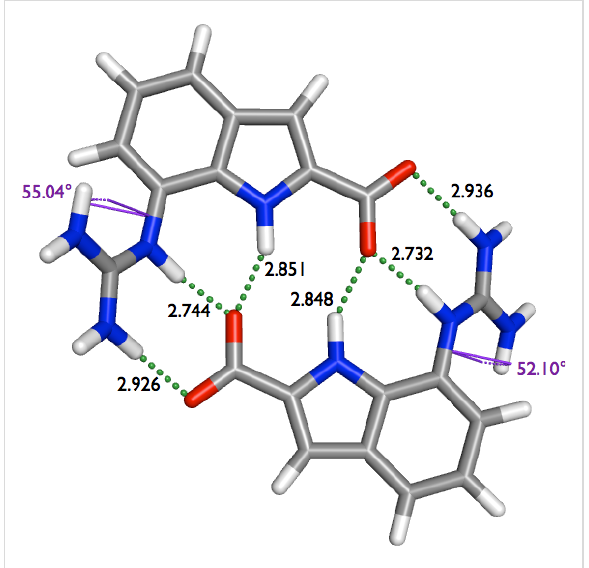
Figure 9: Energy-minimized structure for dimer 2 · 2 with hydrogen bond distances (Å) and dihedral angles.